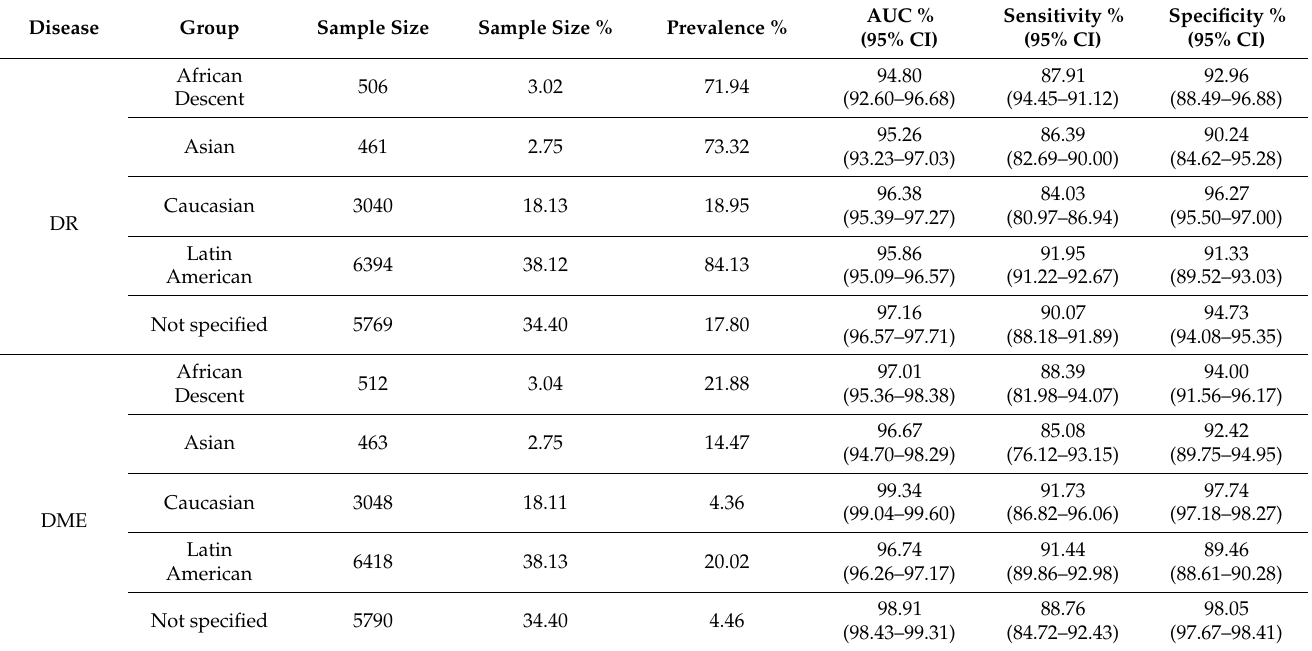
Table A2. Stratification results for detecting referable retinopathy and diabetic macular edema on the patient level for ethnicity.